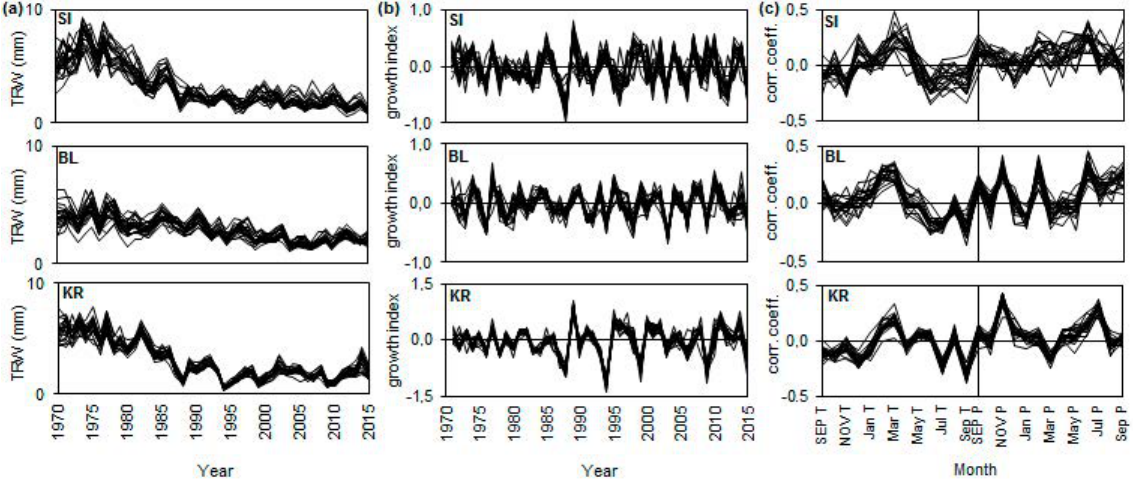
Figure 2. Mean tree ring width ( a ) and indexed ( b ) chronologies of the larch provenances and a series of correlation coefficients ( c ) for the provenance trials in Siemianice (SI), Bli˙zyn (BL) and Krynica (KR), as calculated between the indexed chronologies and mean monthly air temperature (T) and total monthly precipitation (P) for 13 consecutive months from September of the previous year (SEP) to September of the year of tree ring formation (Sep). Table 3. Chronology statistics for sample populations of larch provenances growing during the provenance trials in Siemianice (SI), Bli˙zyn (BL) and Krynica